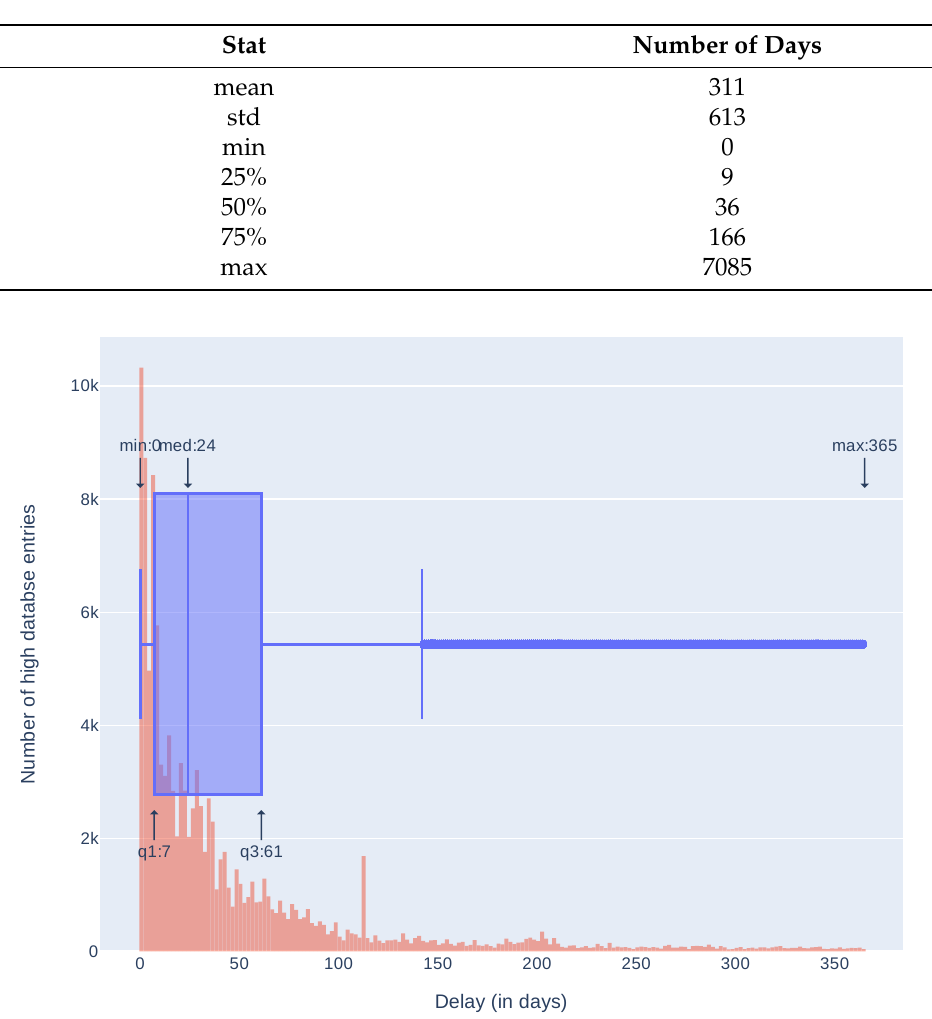
Table 3. Statistics of differences in release dates..